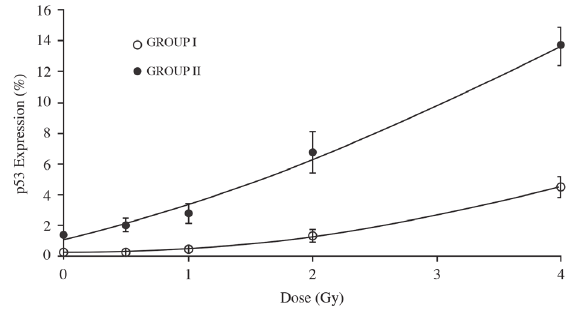
Figure 1 - Mean percentage of the p53 protein expression levels in non-irradiated (0 Gy) and irradiated (0.5; 1; 2; 4 Gy) lymphocytes for Groups I and